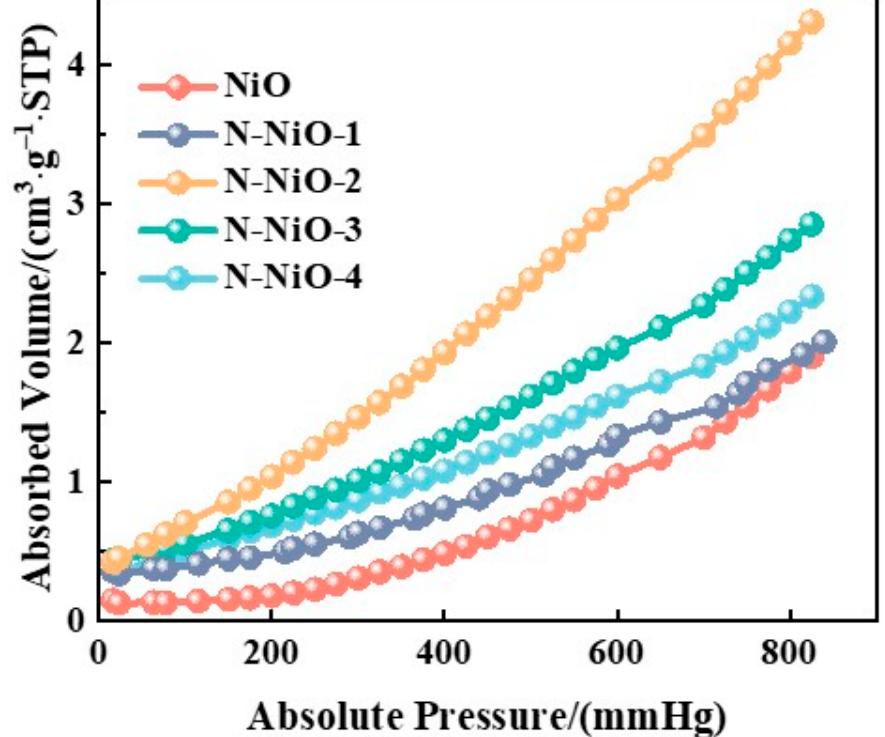
Figure 9. CO 2 -adsorption isotherms of NiO and N-NiO-x.